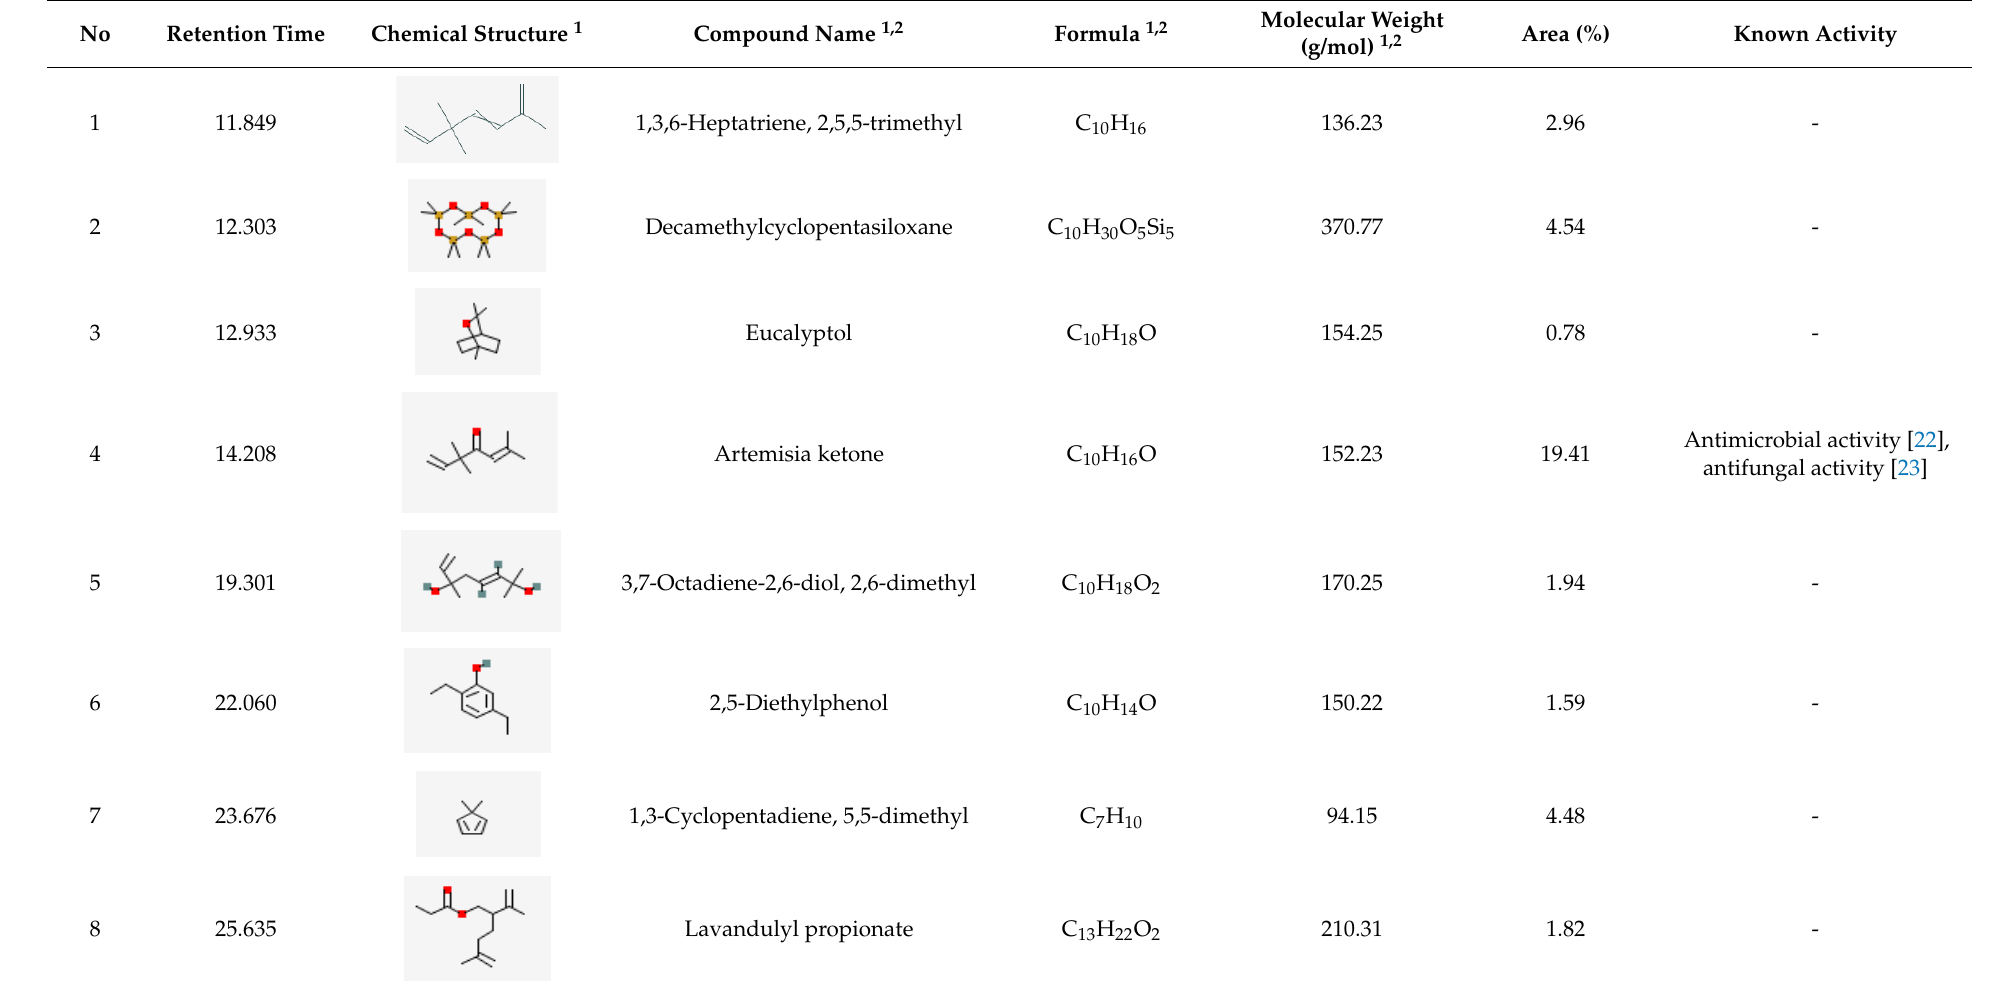
Table 4. GC-MS analysis of AFEt.